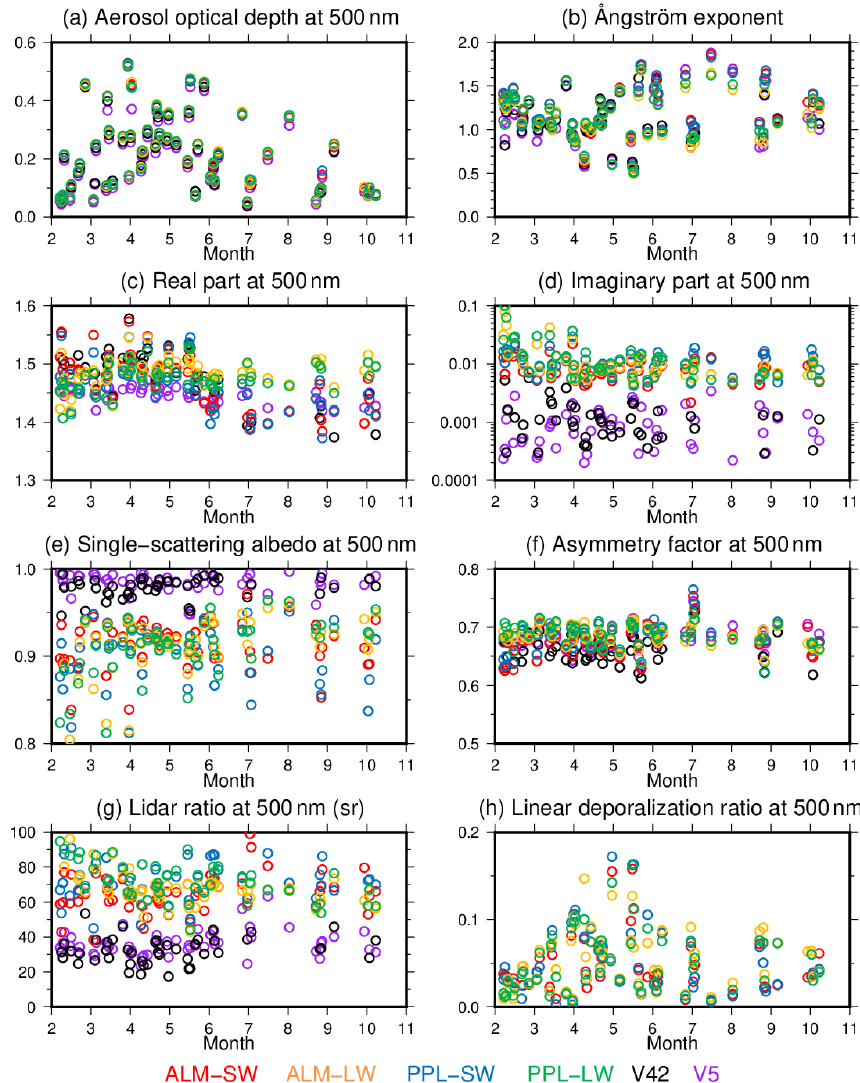
Figure 6. Daily means of aerosol optical depth (a) , Ångström exponent (b) , real (c) and imaginary (d) parts of the refractive index, single- scattering albedo (e) , asymmetry factor (f) , lidar ratio (g) , and linear depolarization ratio (h) . Colors indicate the ALM-SW (red), ALM-LW (yellow), PPL-SW (blue), PPL-LW (green), V42 (black), and V5 (purple) retrieval